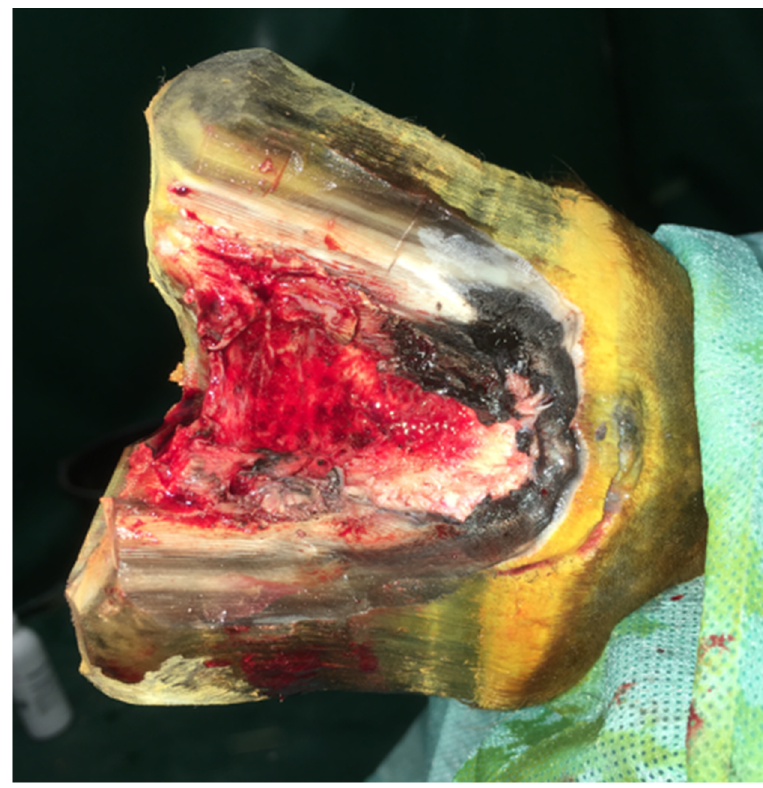
Figure 4. View of the hoof after resection of the keratoma.